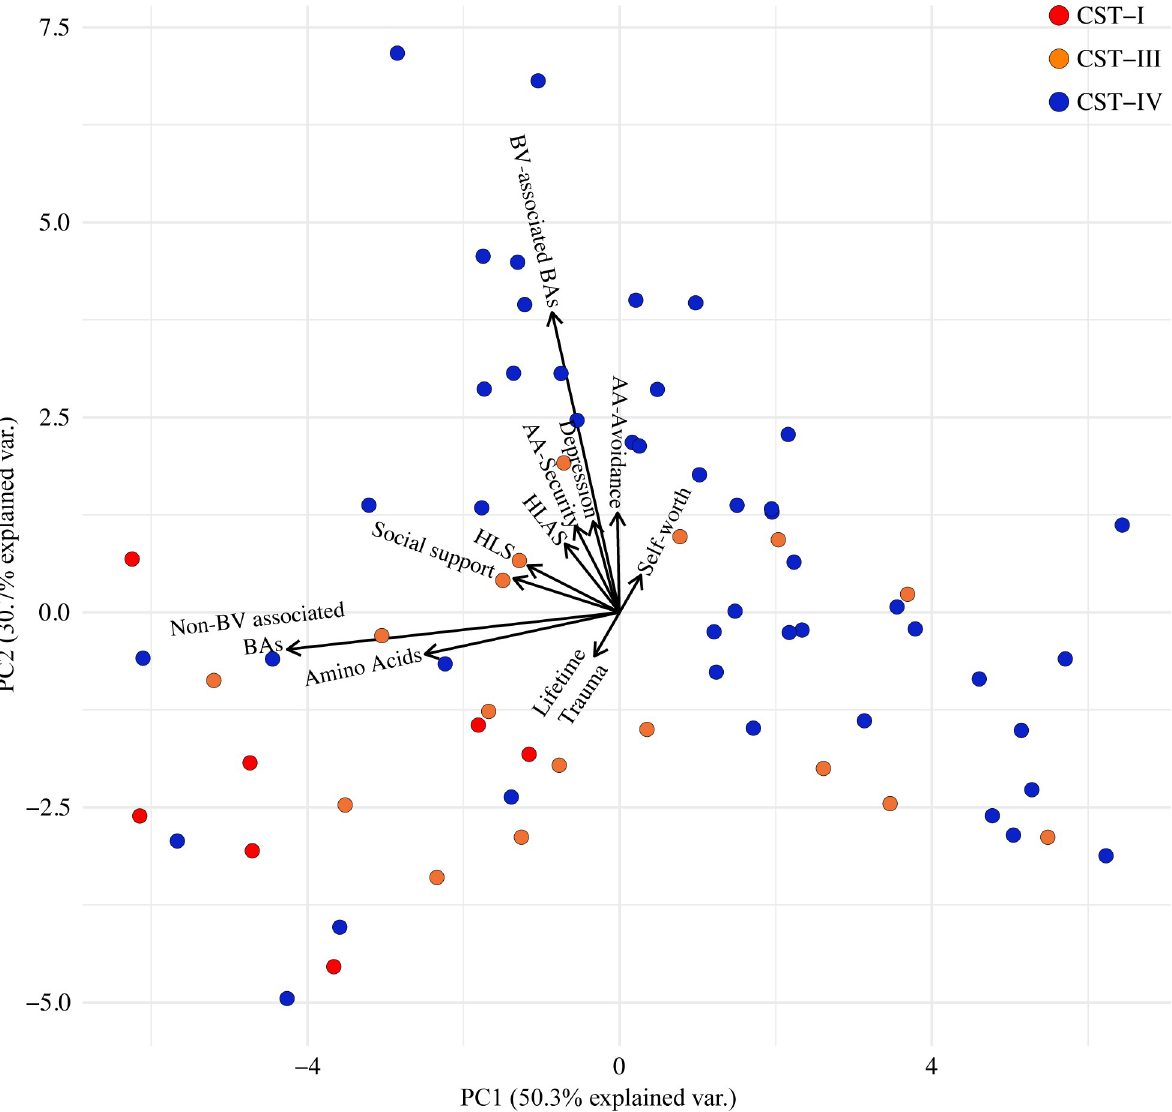
Fig 2. Associations of measures of psychosocial stress, the vaginal microbiota, and vaginal metabolites PCA biplot. Circles represent individuals color coded by CST and black arrows indicate the two principal component loading vectors.